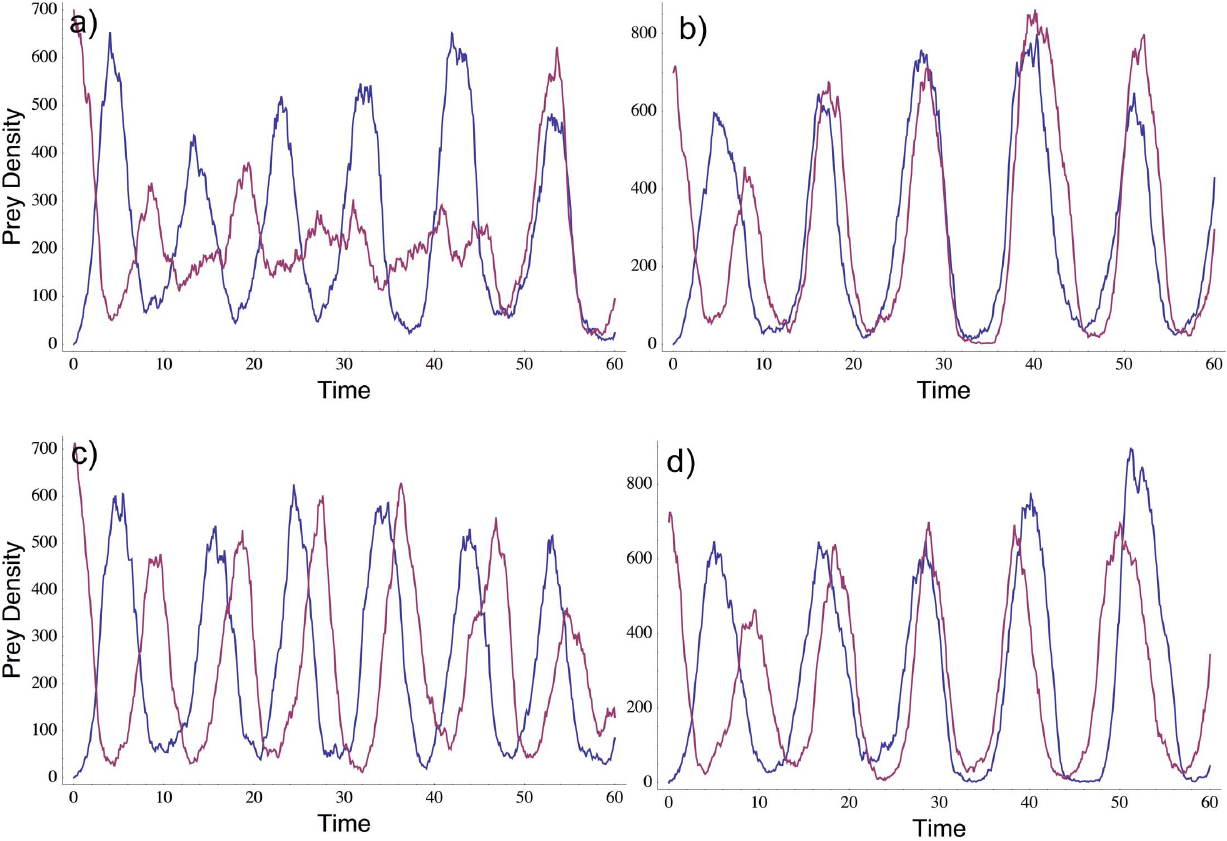
Figure 1. Variation in realized synchrony due to demographic stochasticity. Simulated prey population dynamics in a two-patch Rosenzweig-MacArthur predator-model with demographic stochasticity [33]. In each panel, red and blue lines show prey dynamics in two patches linked by dispersal of prey and predators at the same per-capita rate. The four panels show four different realizations of the model, using the same parameter values and starting from the same, initially-antisynchronous state. Because the model is stochastic, different realizations can have very different behavior, including (a) slow achievement of synchrony (after , 50 time units in this example), (b) rapid achievement of synchrony (after , 12 time units) which is subsequently maintained, (c) failure to achieve synchrony during the simulated time period, and (d) achievement of synchrony (after , 25 time units) which is subsequently lost. Dynamics were simulated using the SSA algorithm of [33], using the following parameter values: attack rate 0.01, handling time 3.0, predator per-capita mortality rate 0.5, predator conversion efficiency 0.4, prey intrinsic rate of increase 2.0 (= per- capita birth rate 3.0 - per-capita mortality rate 1.0), prey carrying capacity 1000, prey and predator per-capita dispersal rate 0.05.